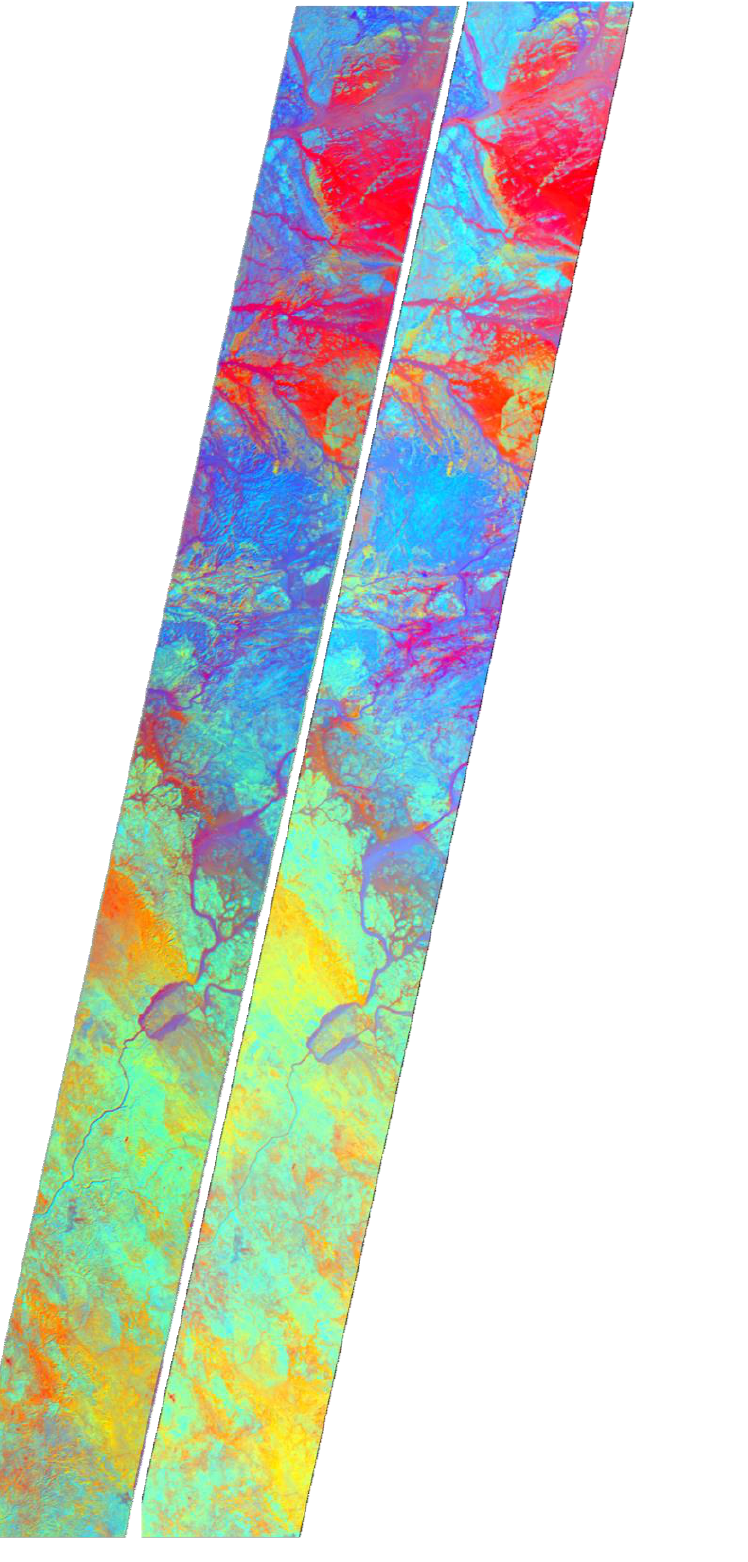
Figure 8. Original ( left ) versus predicted ( right ) principal component analysis (R = PC1, G = PC2, B = PC3).